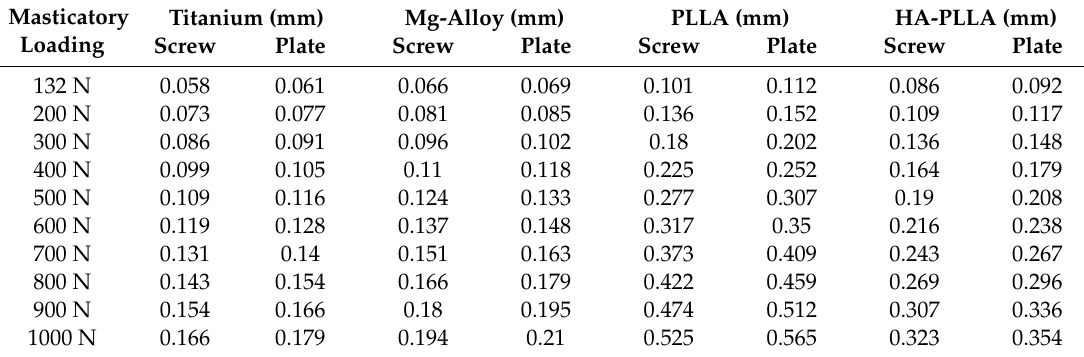
Table 3. Material deformation on masticatory loading according to the material: regardless of the material, deformation was greater in plates than in screws. The deformation level of HA-PLLA is between the two extreme levels of titanium and PLLA.